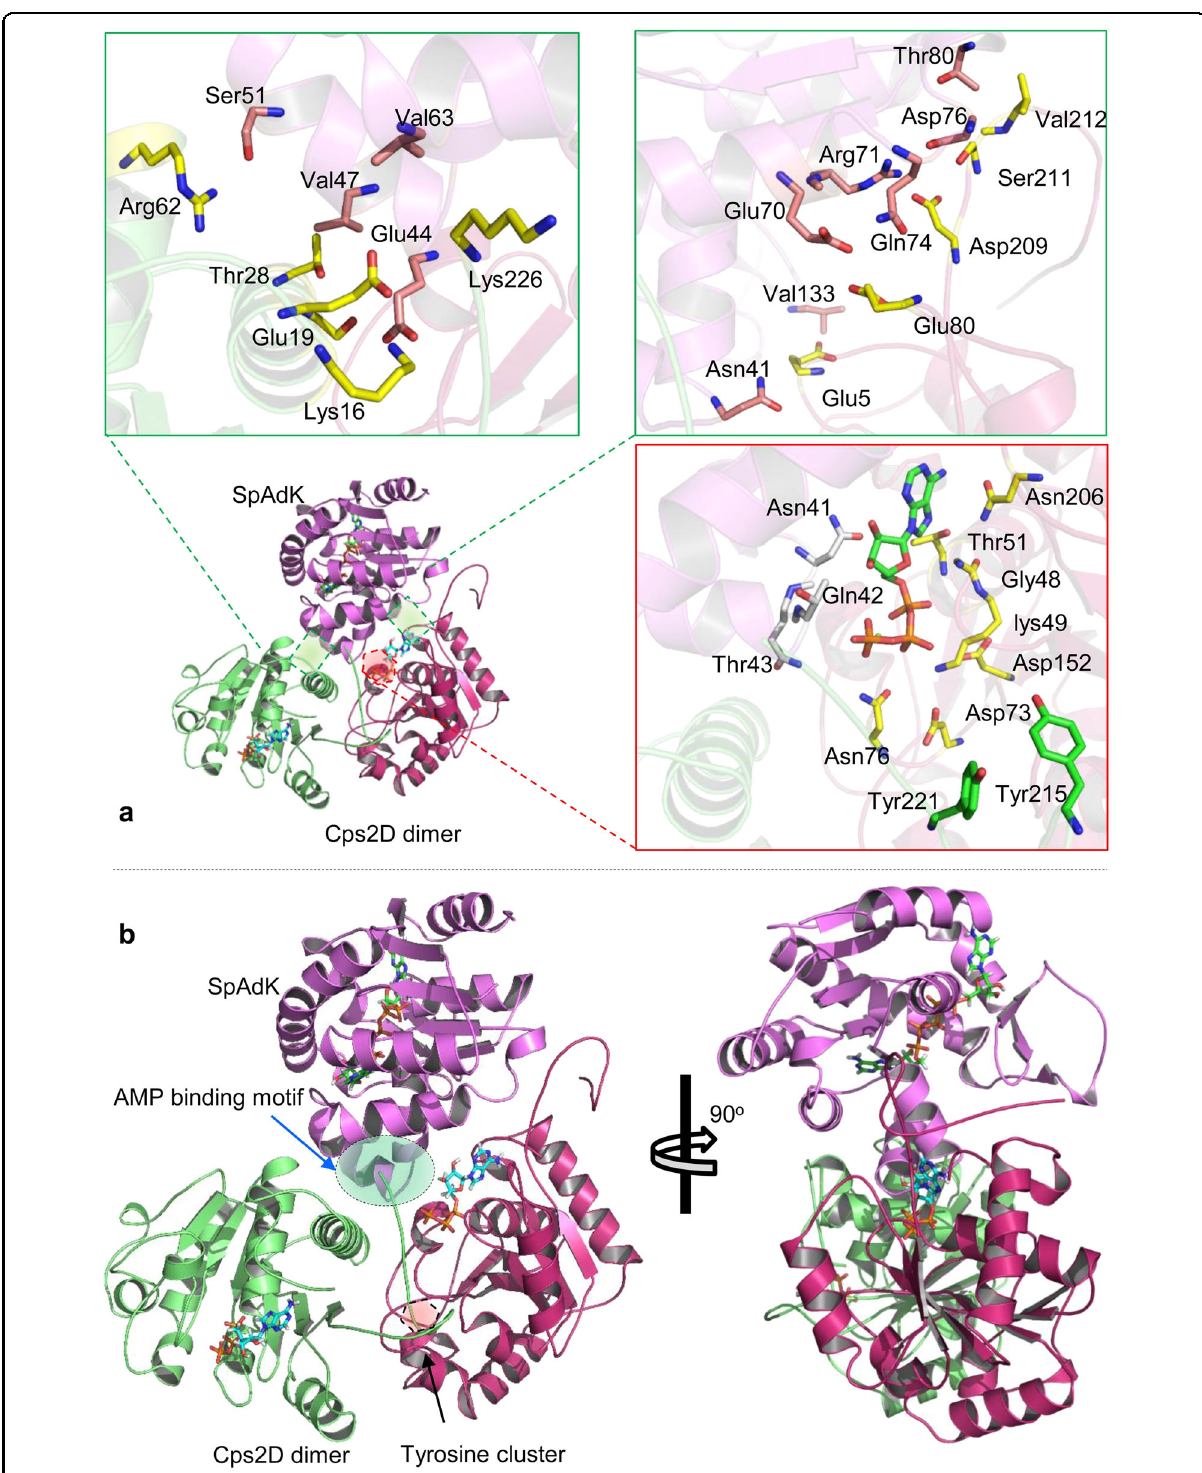
Fig. 7 The binding mechanism of Cps2D and SpAdK. a The binding interface of the trimeric (Cps2D) 2 SpAdK. Green boxes highlight the protein interface of SpAdK with each monomeric Cps2D. The red boxes illustrate the role of ATP and the ATP-binding interface in the Cps2D – SpAdK interaction and the autophosphorylation mechanism. b Front and lateral views of the (Cps2D) 2 SpAdK complex. The red shaded area highlights the C-terminus tyrosine cluster bound to the active site of Cps2D, whereas the green shaded area illustrates the “ V ” -shaped AMP-binding motif of SpAdK anchoring oligomeric